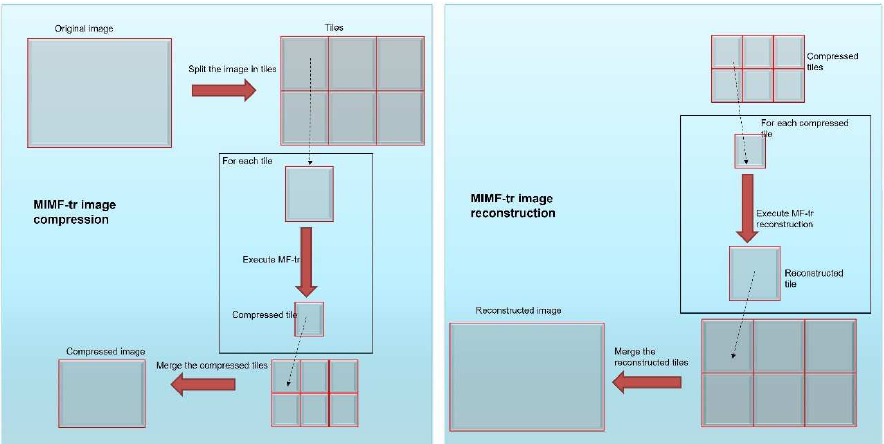
Figure 1. Schema of the MIMF-tr compression and reconstruction algorithms. The Peak Signal to Noise Ratio (PSNR) measure is used to measure the quality of the compression. Each tile is partitioned in blocks and each block is compressed using the MF- tr compression method, in which the iteration process with the execution of the subse- quent level continues until the PSNR of the decompressed block is greater than or equal to a fixed threshold.